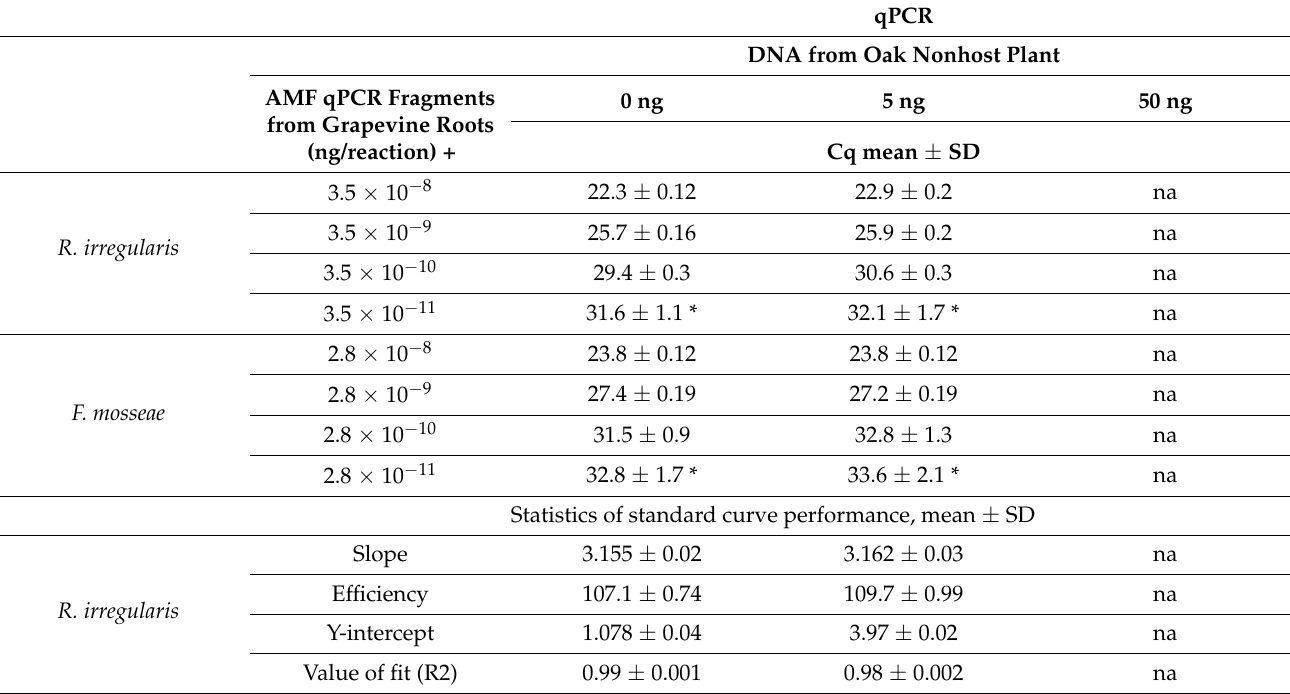
Table 1. The qPCR inhibitors and limits of quantification estimated by qPCR standard curve. DNA of AMF nonhost roots from oak plants (0, 5 and 50 ng/qPCR reaction) spiked with serial dilutions AMF qPCR fragments (S1_V1 sample, for R. irregularis, S10_V3 sample and F. mosseae , respectively). The experiments were assessed in triplicate over three independent experiments (n = 9). Cq, quantification cycle; SD, standard deviation; na, not amplified. *, four replicates amplified of nine